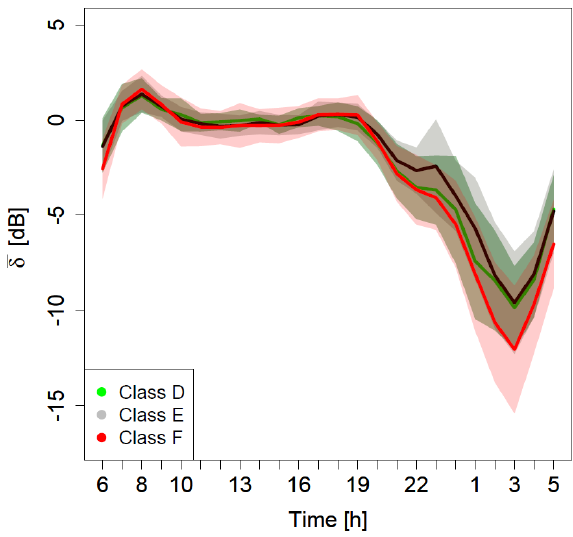
Figure 4: 24-h mean normalized noise level profiles, δ of the 93 monitored sites with the corresponding standard deviation band grouped by functional classes. Roads of class A have been excluded because of poor statistical